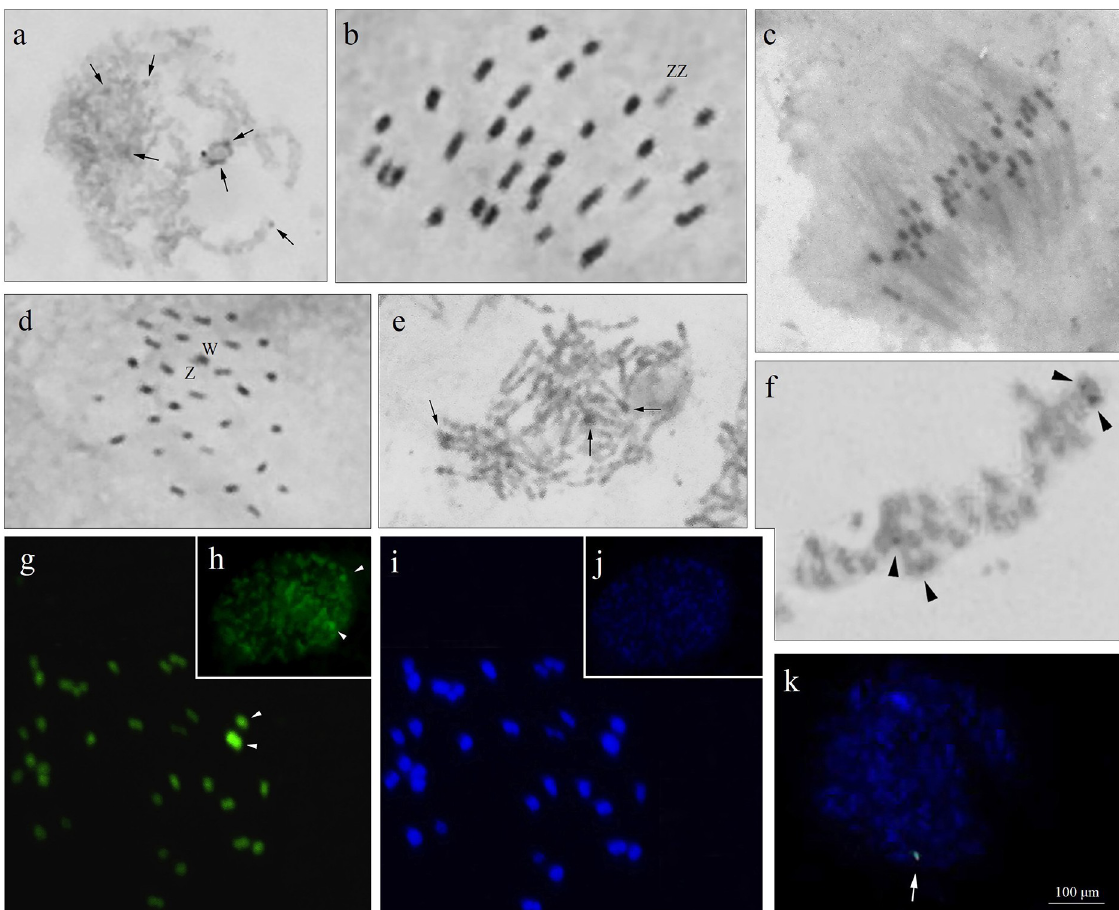
Fig 1. Meiocytes of A . gemmatalis submitted to conventional staining by Giemsa (a-f) and fluorochromes CMA 3 /DAPI (g-j). (a) pachytene; (b) male metaphase II; (c) anaphase II; (d) female metaphase II; (e) pachytene submitted to the C-banding; (f) male metaphase II with C-banding. arrows indicate the heterochromatic regions; (g) metaphase I. Note the two divalent CMA 3+ ; (h) interphase nucleus; (i) metaphase I (DAPI); (j) interphase nucleus; (k) interphase nucleus after fluorescence in situ hybridization with biotin-labeled 18S DNAr probe and counterstained with DAPI. Note the detail of the unique marking with 18S